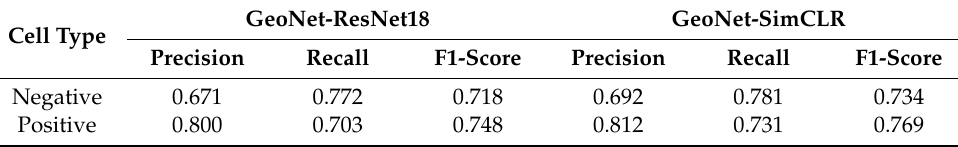
Table 2. Numerical detection results for unlabelled images in the LUSC data set.